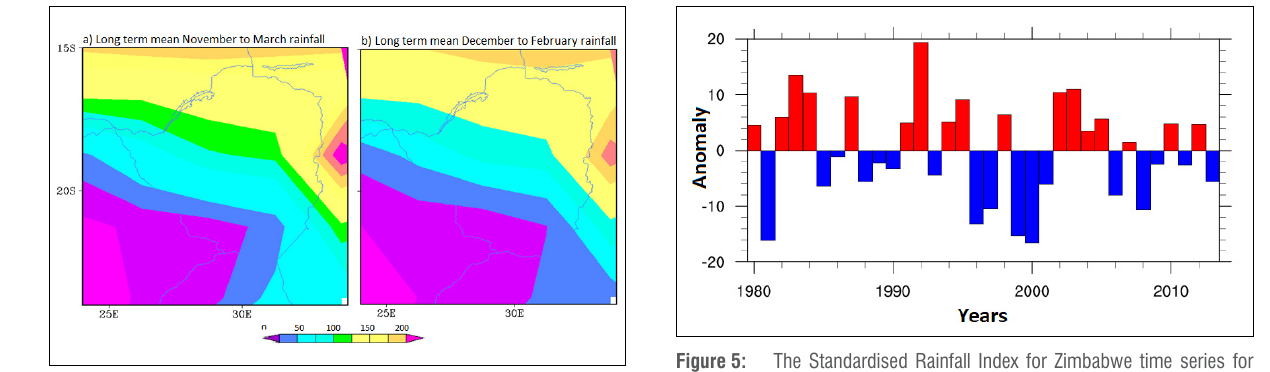
Figure 4: Long-term mean maps for Zimbabwe summer rainfall (in mm) for the period 1980 to 2013 for the November to March and December to February periods.